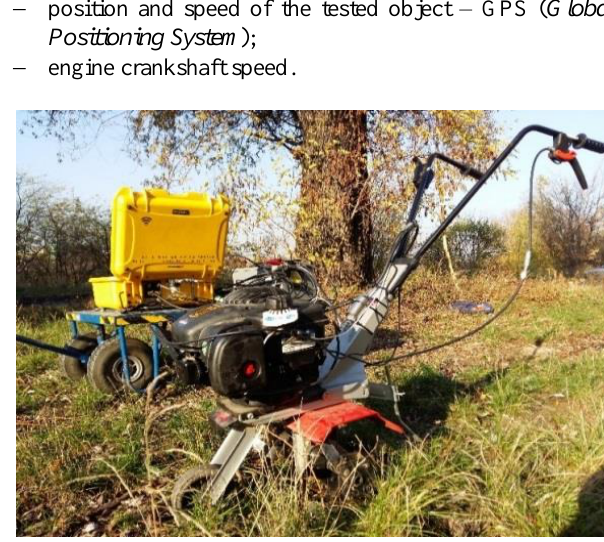
Fig. 1. Measuring system in real operating conditions